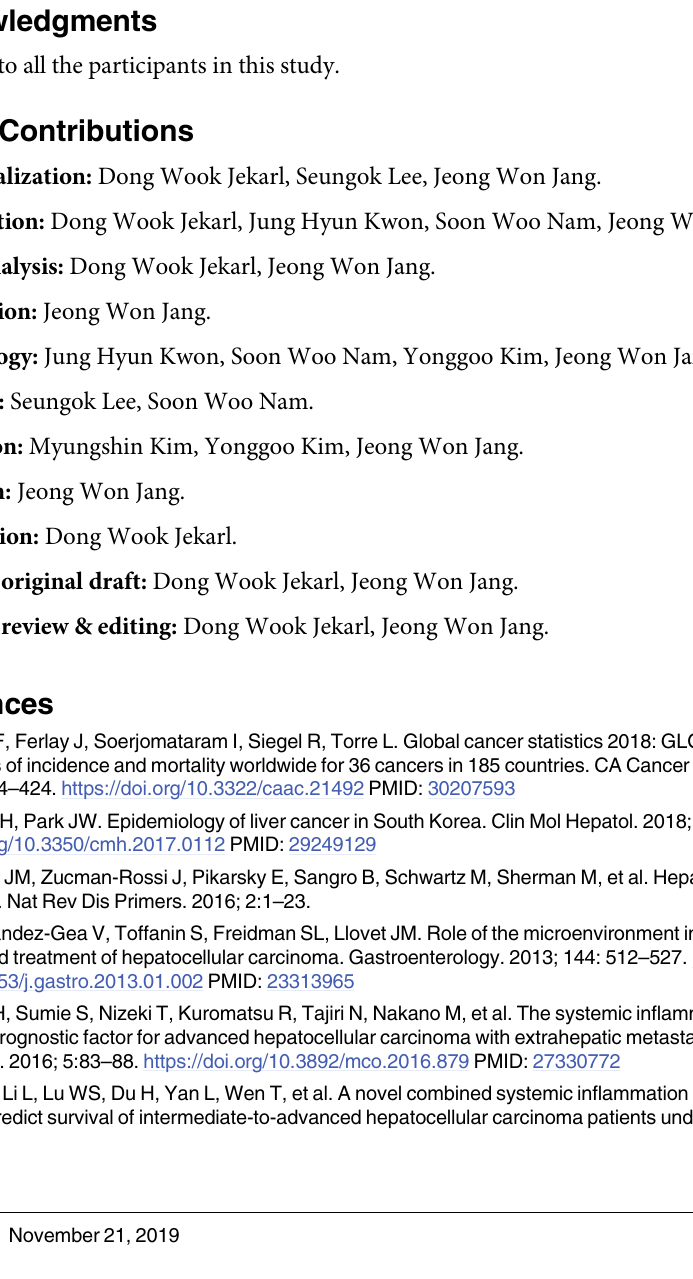
S10 Table. Topological parameters from network analysis of D3. S11 Table. Topological parameters from network analysis of D7. S12 Table. Topological parameters from network analysis of D60. S13 Table. Univariate and multivariate analysis by Cox regression analysis for D0 and D3. S14 Table. Univariate and multivariate analysis by Cox regression analysis for D7 and